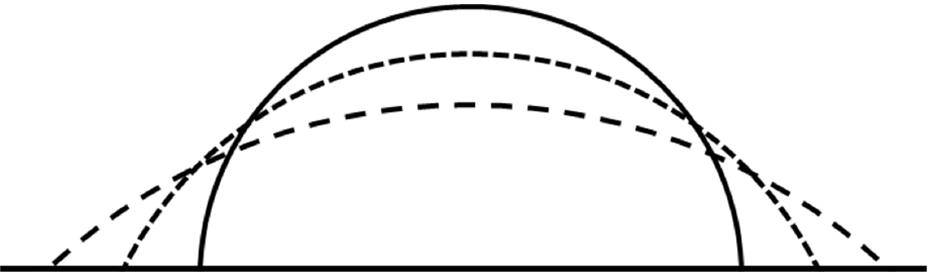
Figure 1. Drop shapes during spreading. Initial spherical cap ( solid line ), transition shape ( short-dashed line ), steady state “pancake” shape ( long-dotted line ).